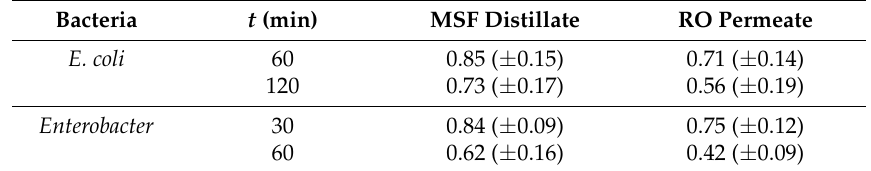
Table 5. Average (n = 21) concentration of bacteria in control samples of MSF and RO water relative to the concentration at initial time ( N ct / N co ). Values in parenthesis represent standard